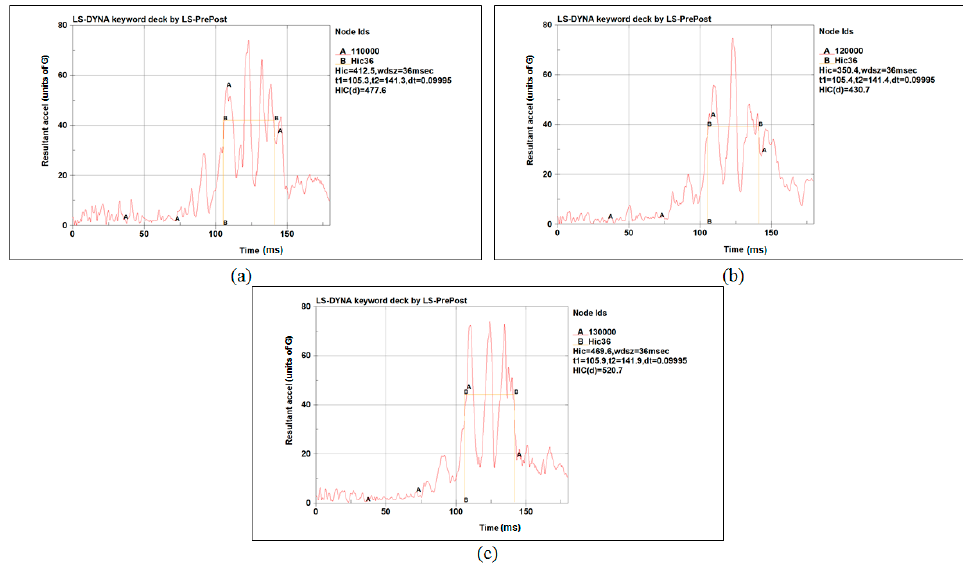
Figure 15. Test 1: Lumbar compressive force (KN) vs. time (ms) of ( a ) Dummy 1, ( b ) Dummy 2 and ( c ) Dummy 3.